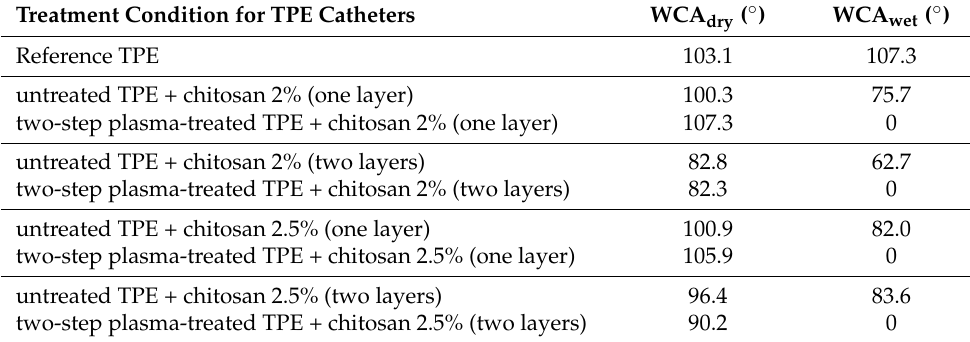
Table 8. Water contact angle (WCA) of TPE catheters with the coatings. Treatment Condition for TPE Catheters